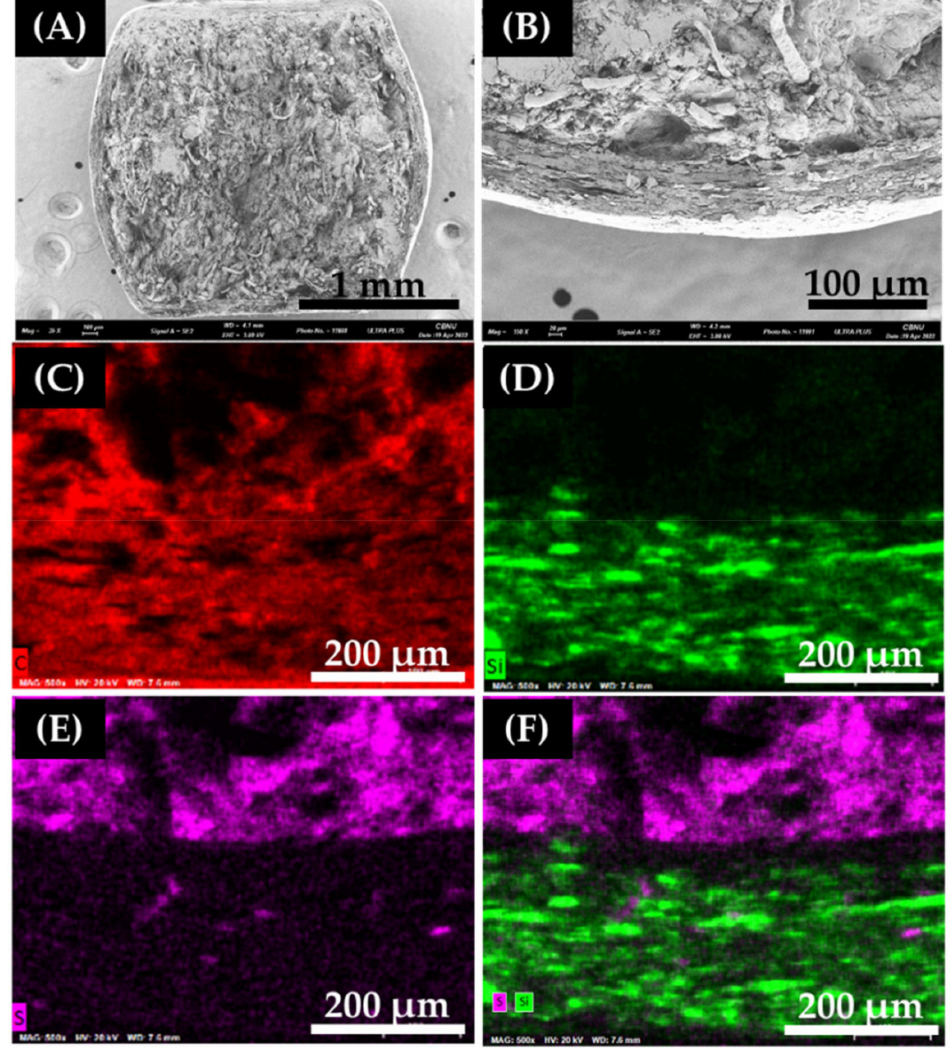
Figure 5. SEM image and SEM-EDS mapping of coated EMP mini-tablet (Formulation code: I-2). ( A ) Cross-section (Magnification: × 36), ( B ) Coating layer (Magnification: × 150). ( C – E ) shows SEM-EDS mapping of C, Si, and S atom, respectively (Magnification: × 500). ( F ) Merged image of ( D , E ) (Magnification: ×